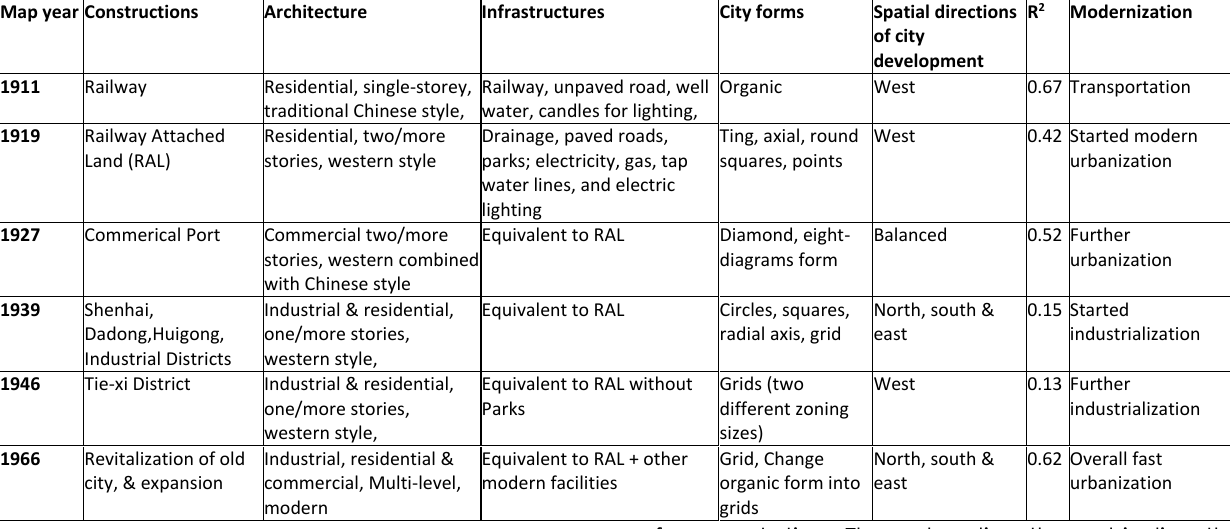
Table 2. A summary of city construction status in Shenyang